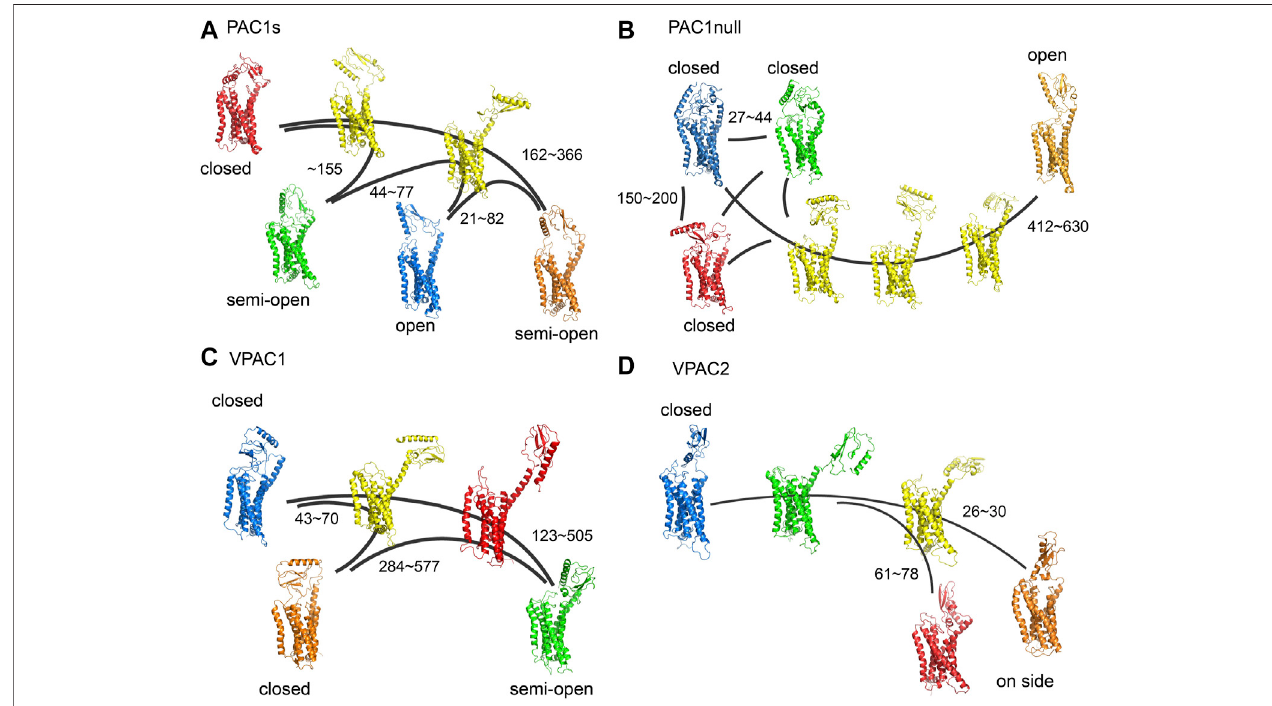
FIGURE 1 | (A) Transition pathways for (A) PAC1s, (B) PAC1null, (C) VPAC1 and (D) VPAC2 receptors. Stable conformational states are colored in blue, red, green,andorangerespectively.Intermediatestatesarecoloredinyellow.MostintermediatestatesareECD-unrestrictedconformations.TheVPAC1conformationinred and the VPAC2 conformation in green also belong to the ECD-unrestricted conformational ensemble. PAC1null is remade from our recent study (Liao et al., 2017). The kinetic transition time between certain conformational states are labeled with units in